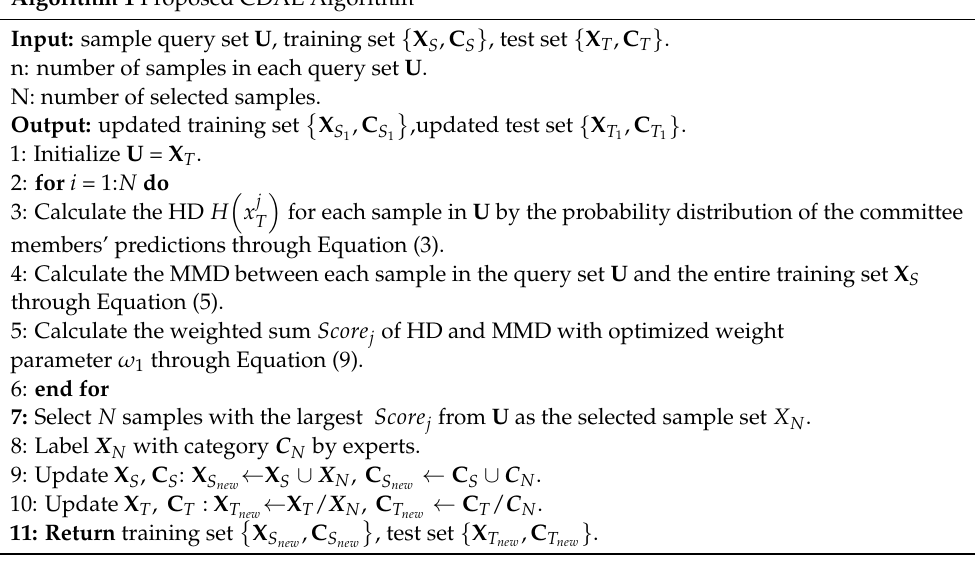
Algorithm 1 Proposed CDAL